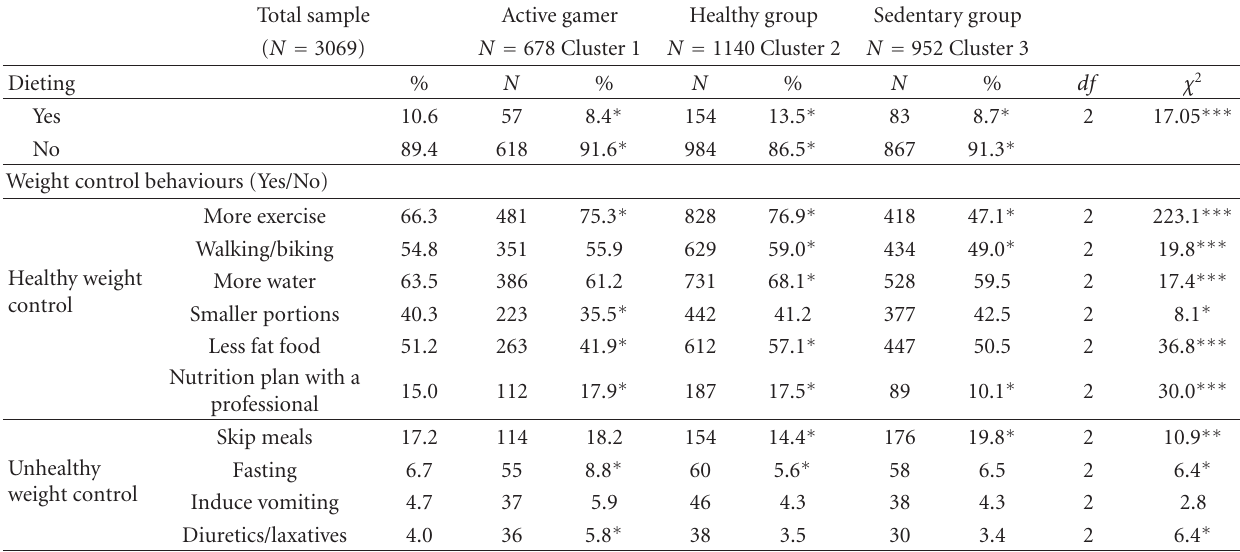
Table 4: Prevalence of dieting and weight control behaviours within